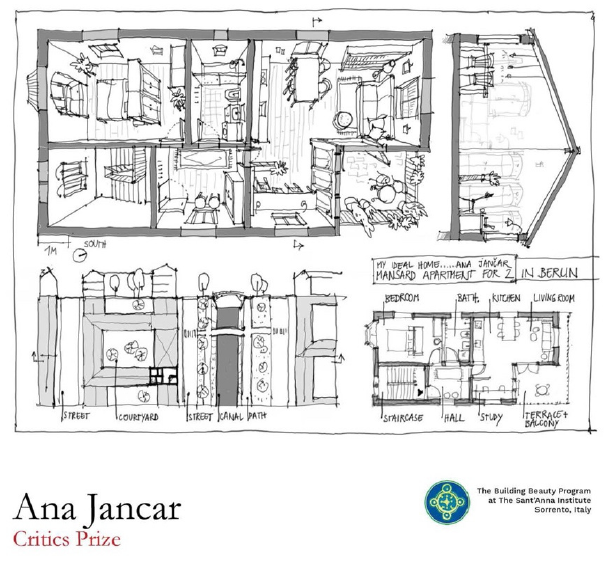
Figure 8. Rather than express the priority of making an object this winning entry to Building Beauty's 2018 HOME competition expresses the value of density and expression in the urban context.